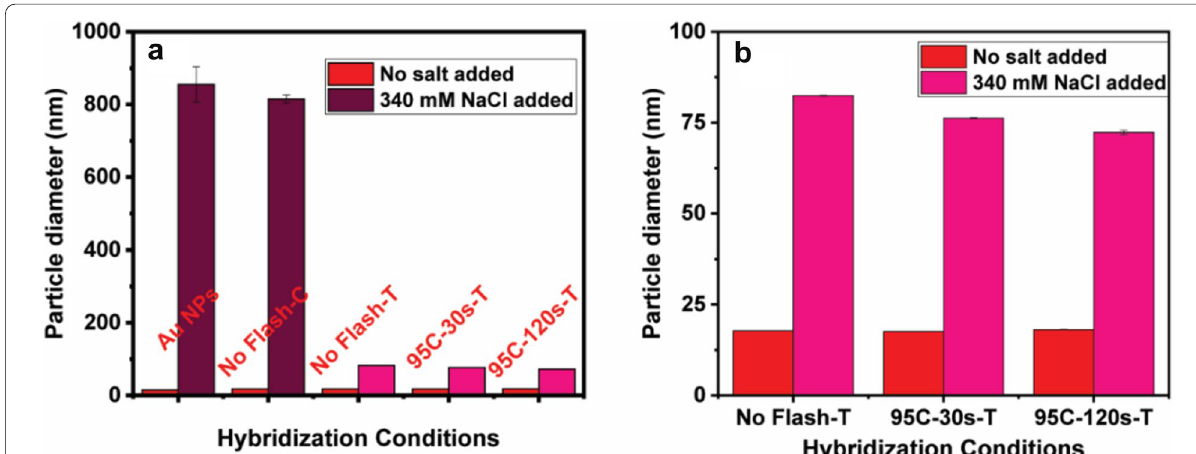
Fig. 5 Effect of particle aggregation measured through the dynamic light scattering analyses over Au NPs in citrate buffer before and after addition of 340 mM NaCl: a panel showing the effect of salt-induced aggregation over citrate-capped Au NPs, control sample without any flash heating, and target subjected to three different hybridization conditions. The concentration of probe, target (T), and control (C) were fixed as 3 μM. b Zoomed in data of the target samples subjected to different hybridization conditions shown in ( a